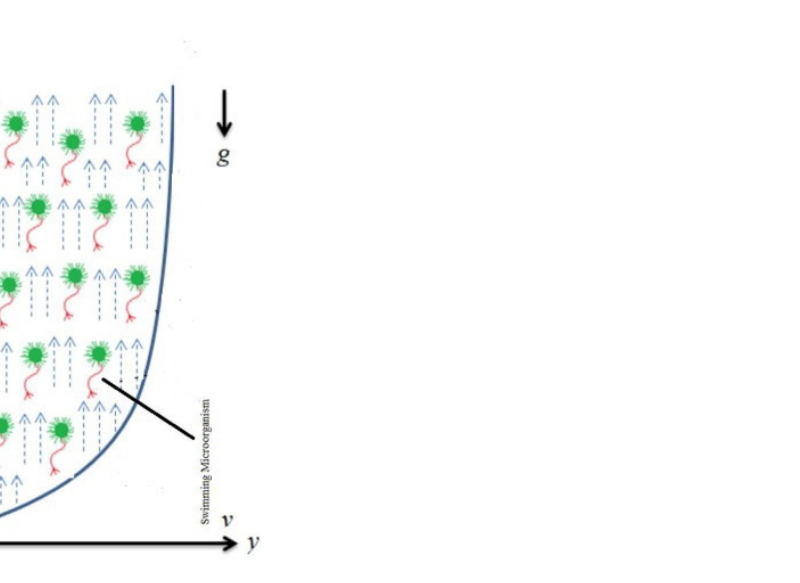
Figure 1. Geometry of the